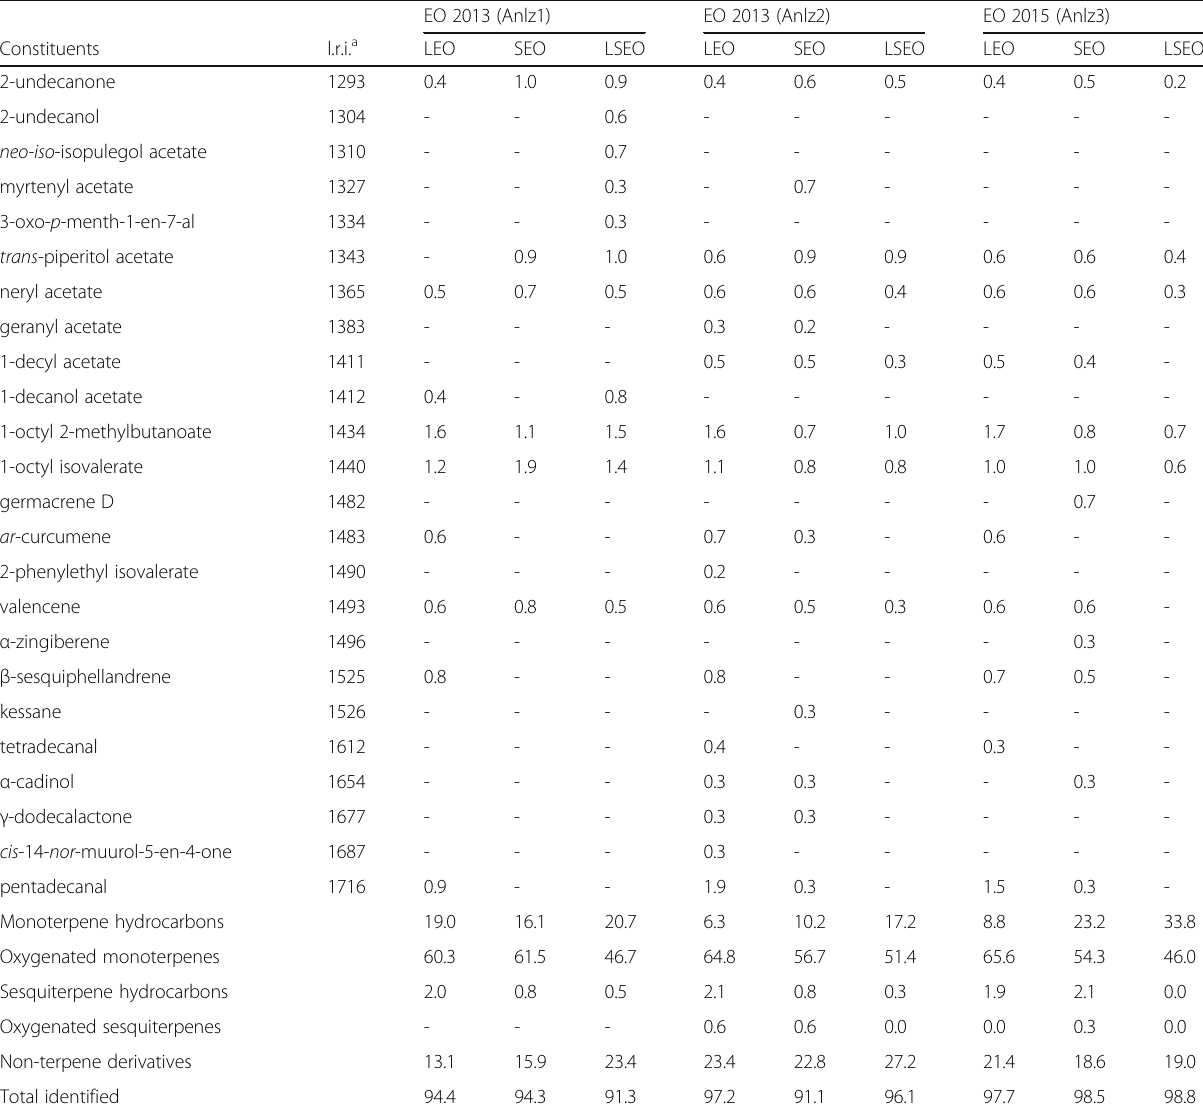
Table 1 Chemical composition of the essential oil of Haplophyllum tuberculatum vegetal parts